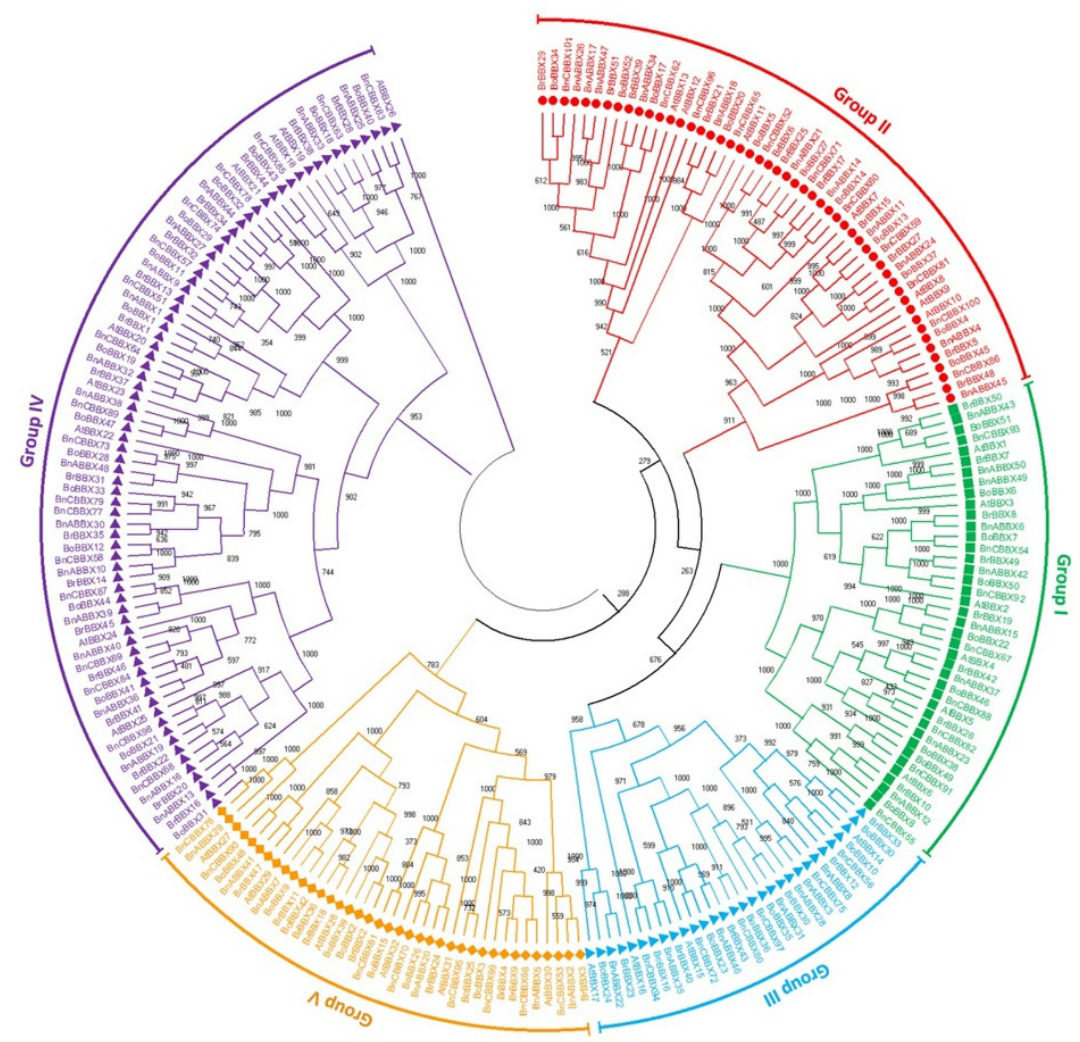
Figure 2. Phylogenetic tree of B-box genes from Brassica rapa , B. napus , B. oleracea , and Arabidopsis thaliana. The phylogenetic tree was constructed according to the neighbor-joining method. The unrooted tree was generated using MEGA5 on the basis of B-box amino acid sequences from B. rapa , B. napus , B. oleracea , and A. thaliana. Roman numerals (I–V) represent different gene clusters. The genes from each species are differentiated by color. The numbers at the nodes represent bootstrap percentage values.